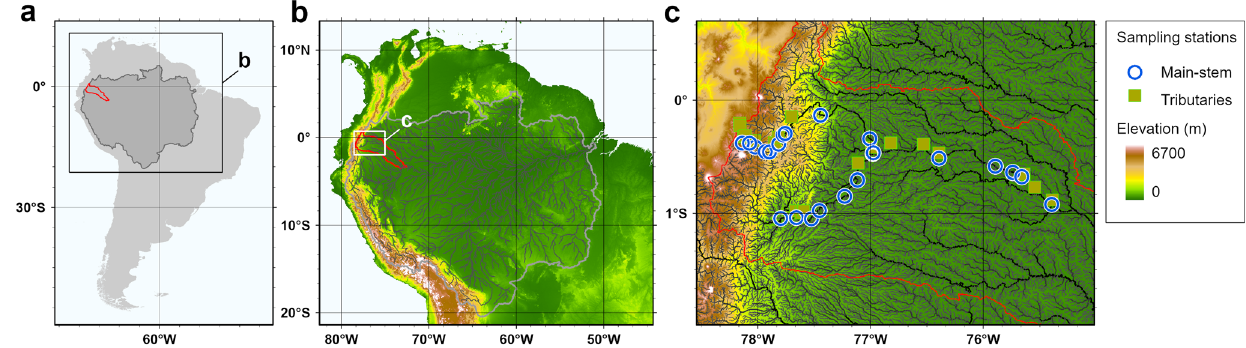
Fig. 1 Location of sampling stations in Andean headwater and piedmont streams of the Amazon basin. a – c The outline of the catchment of the Napo River is shown in red, stations in the main-stem are shown by blue circles and in the tributaries by green